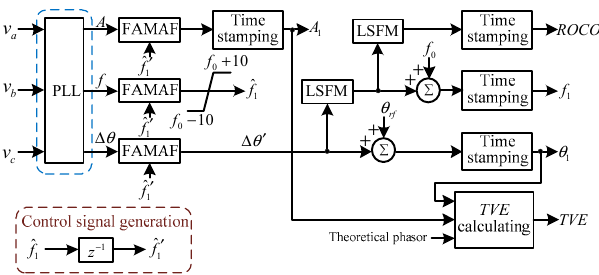
Figure 3. The basic structure of proposed fixed length adaptive moving average filter-based p class synchrophasor measurement algorithm (FA-PSMA).